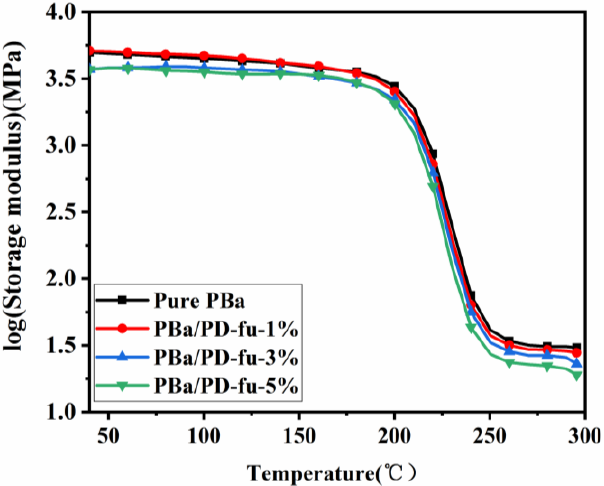
Figure 13. Storage moduli of neat PBa, PBa/PD-fu-1% and PBa/PD-fu-3% and PBa/PD-fu-5%.